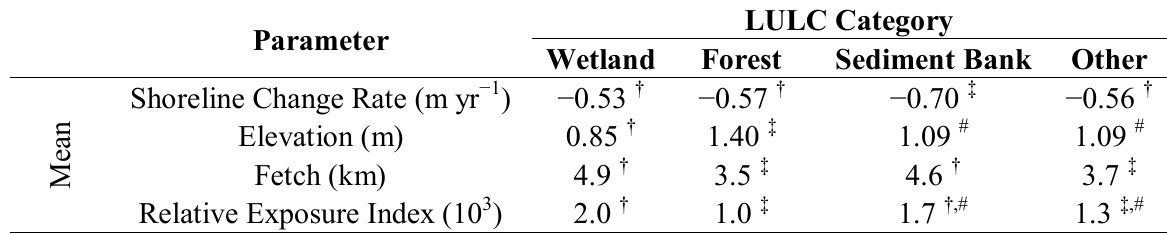
Table 2. Mean parameter values of the four Land-Use Land-Cover (LULC) categories within the Neuse River Estuary study area. Symbols denote the LULC categories that are significantly different for the specified